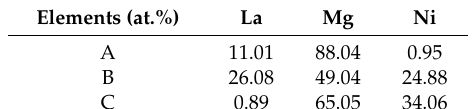
Table 2. EDS analysis of the La 7.0 Mg 75.5 Ni 17.5 alloy.